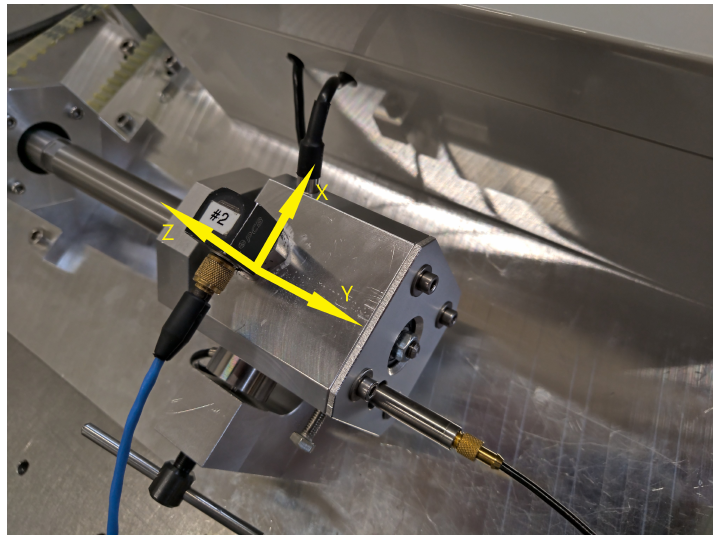
Figure 6. Coordinate system of the triaxial acceleration